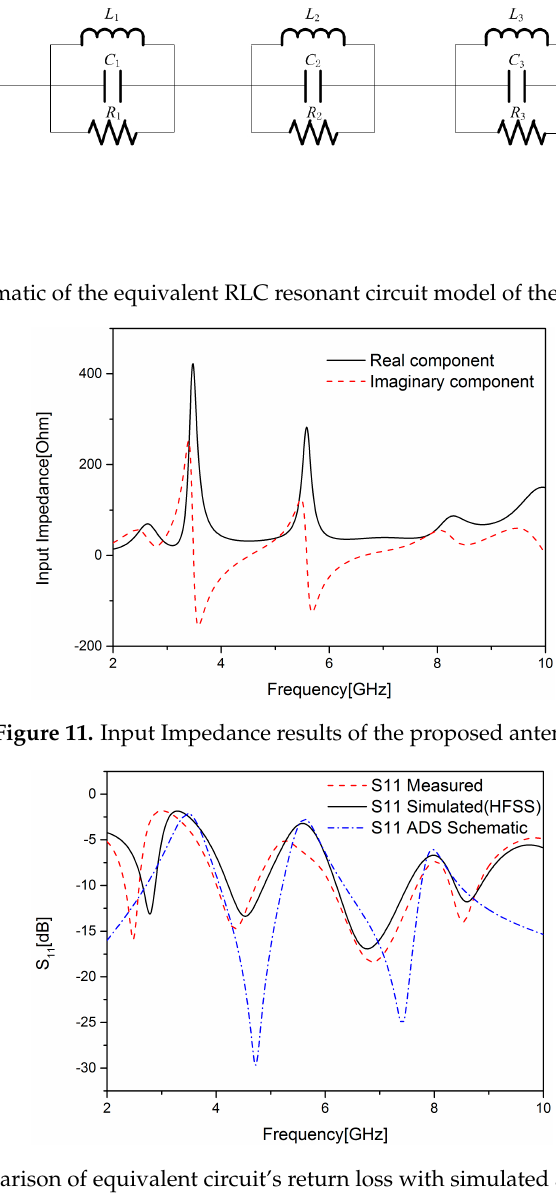
Figure 12. The comparison of equivalent circuit’s return loss with simulated and measured results of return loss of the proposed antenna.